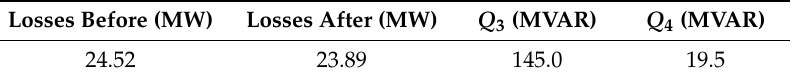
Table 6. Reactive control optimization results.